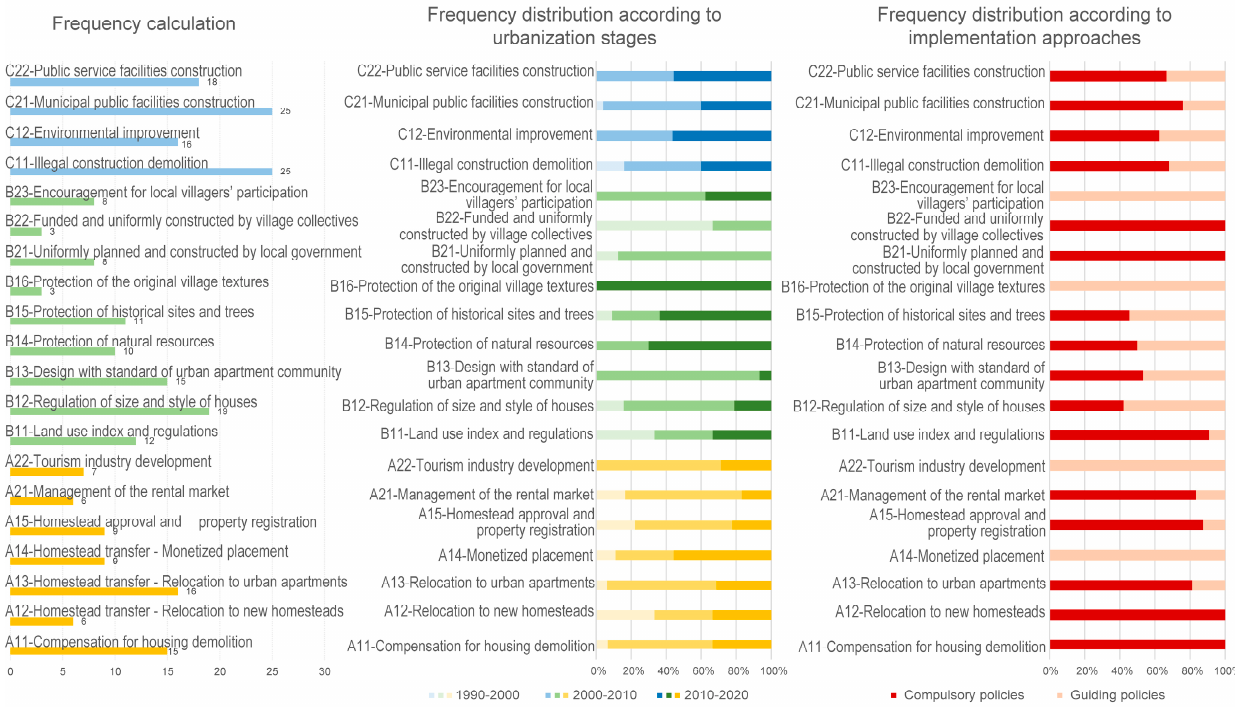
Figure 7. Frequency calculation of keywords and phrases. The results indicate the following: